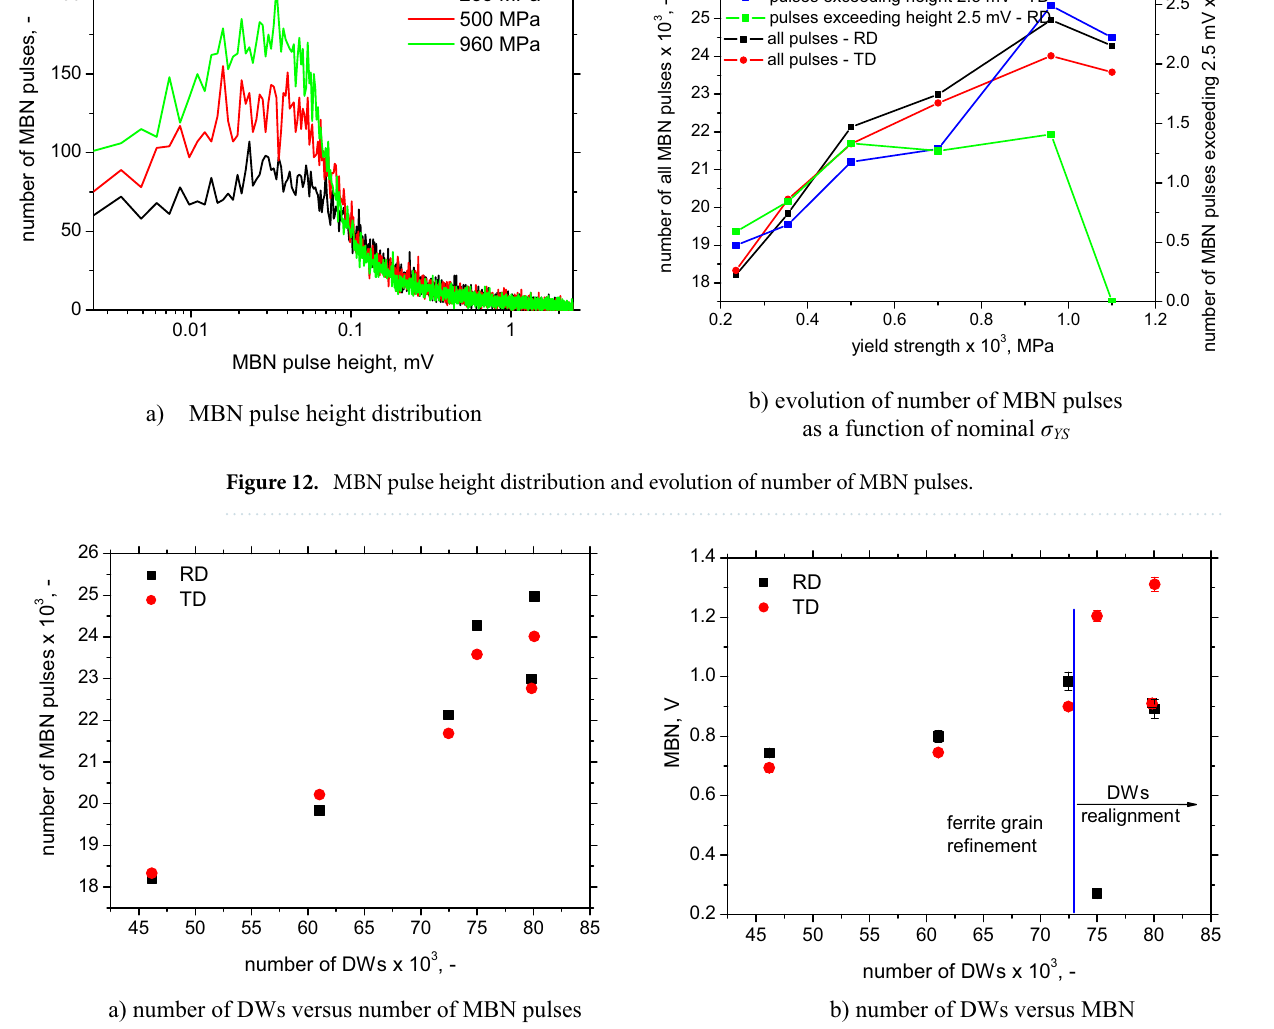
Figure 13. Number of DWs versus number of MBN pulses and number of DWs versus MBN.